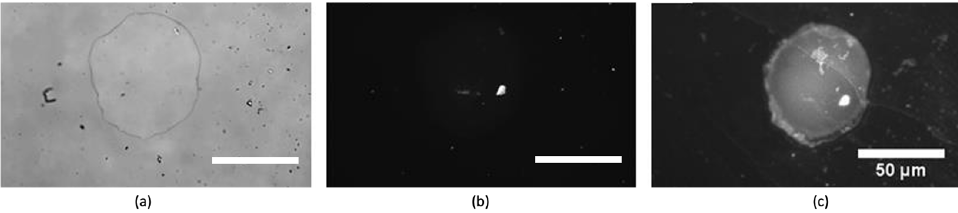
Figure 5. ( a ) Brightfield image of the iniferter-polymerized core; ( b ) corresponding fluorescence image after the core fabrication; ( c ) resulting fluorescence image after MIP grafting.